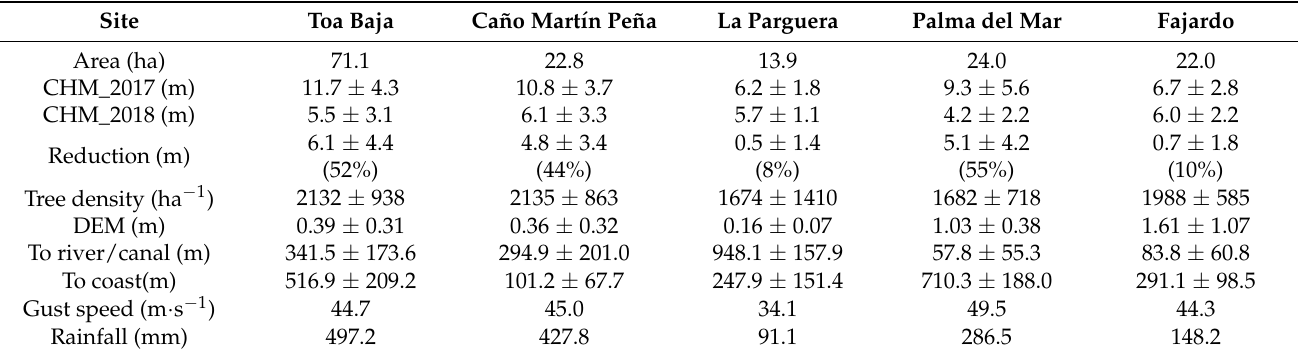
Figure 2. DEM of the five mangrove forests. Blue and light-green lines depict rivers and canals of freshwater/sewage, respectively. Table 2. Summary of the canopy heights before (CHM_2017) and after the hurricanes (CHM_2018), canopy height reduction, algorithm-derived tree density, and the covariates of DEM, distance to rivers/canals and to coast, and hurricane rainfall and gust wind based on the 20 m grid